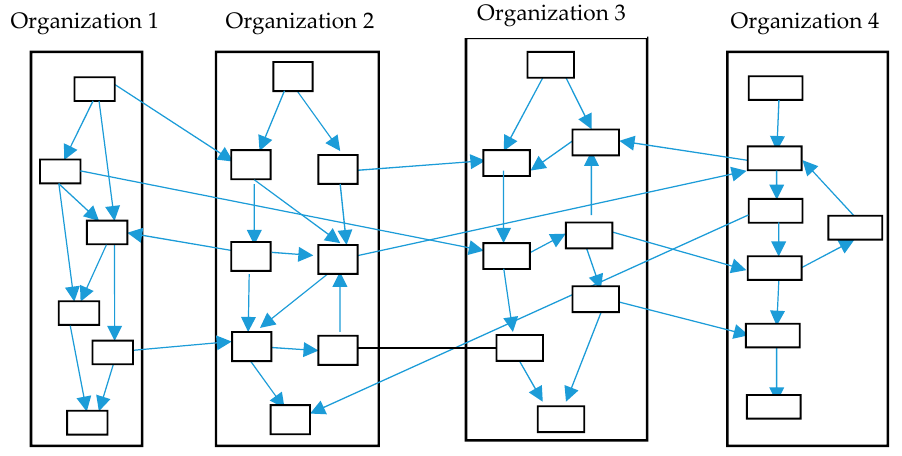
Figure 1. The loosely coupled form of workflow interoperability.